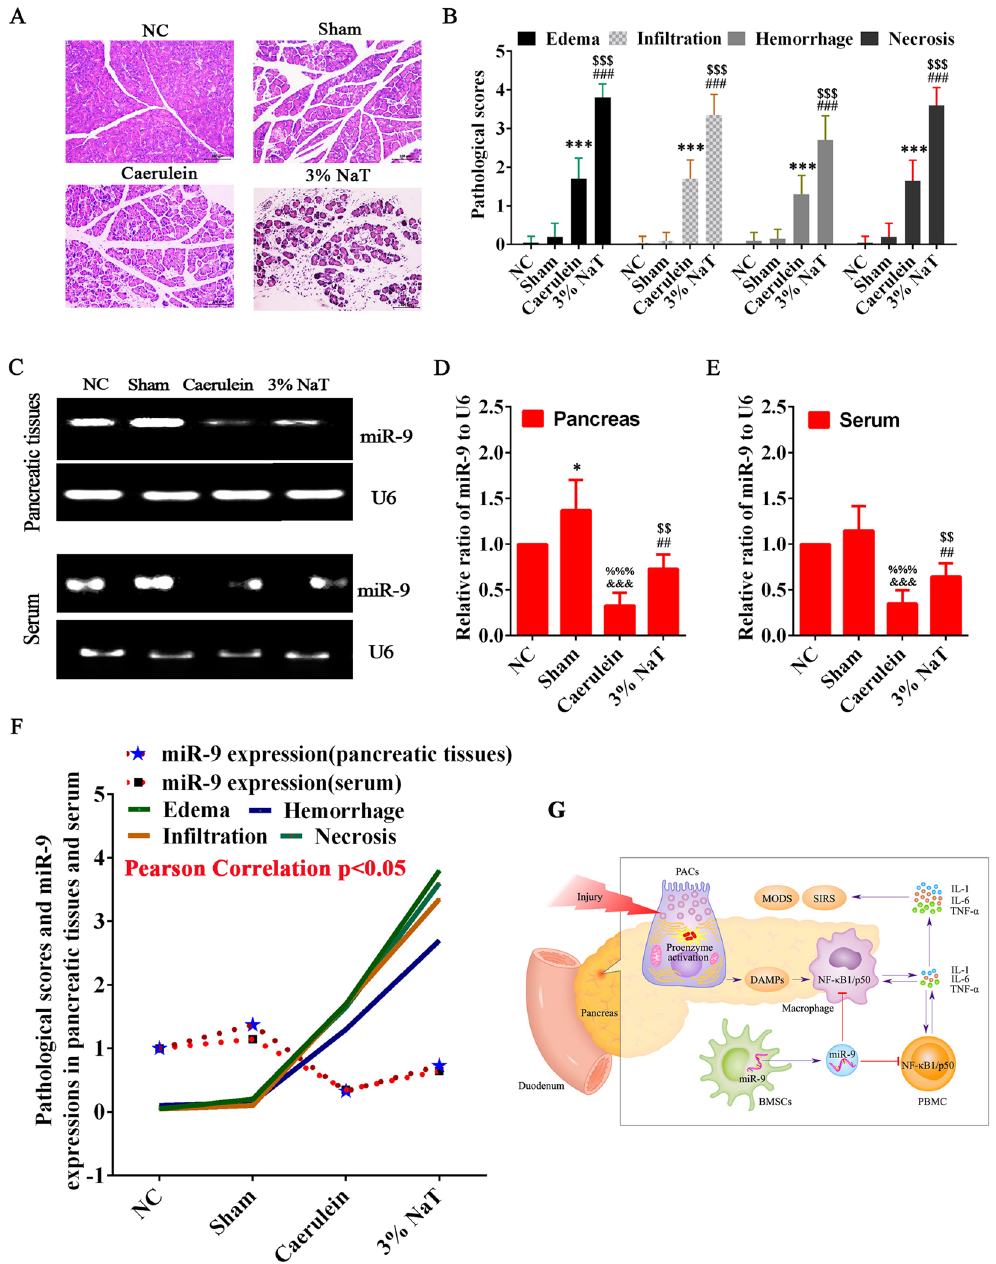
Figure 7. The expression of miR-9 in injured pancreas was negatively correlated with the severity of AP. Interestingly, compared with Caerulein, the expression of miR-9 was significantly up-regulated by 3% NaT. ( A,B ) Rat AP models were induced by Caerulein and 3% NaT and the H&E staining showed that the injury of pancreas in 3% NaT group was more severe than that in Caerulein group. Data are shown as mean ± SD for at least 3 separate experiments. *** p < 0.001 and ### p < 0.001, compared with NC, $$$ p < 0.001, compared with Caerulein by using two tailed t test. ( C,D,E ) The expressions of miR-9 in damaged pancreatic tissues and serum in 3% NaT group were significantly higher than that in Caerulein group, but lower than that in NC or Sham groups. Data are shown as mean ± SD. &&& P < 0.001 and ## p < 0.01, compared with NC, * p < 0.05, compared with NC, %%% p < 0.001, compared with Sham, $$ p < 0.01, compared with Caerulein group by using paired t test. ( F ) The expressions of miR-9 in damaged pancreas and serum were negatively correlated with pathological scores of AP by Pearson correlation analysis (p < 0.05). AP, acute pancreatitis, H&E, hematoxylin eosin, NC, normal control, NaT, sodium taurocholate, SD, standard deviation, miR-9, microRNA-9. ( G ) miR-9, produced by infused BMSCs, can target NF- κ B1/p50 gene and suppress the activation of NF- κ B signaling pathway in PBMC/Macrophage to reduce the release of the pro-inflammatory cytokines and prevent the occurrence of SIRS and MODS, which can promote the repair and regeneration of necrotized pancreatic